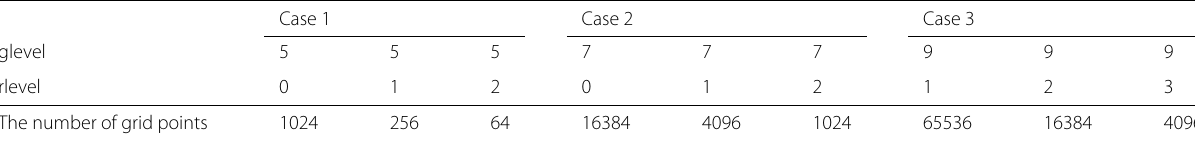
Table 7 Number of horizontal grid points per processor